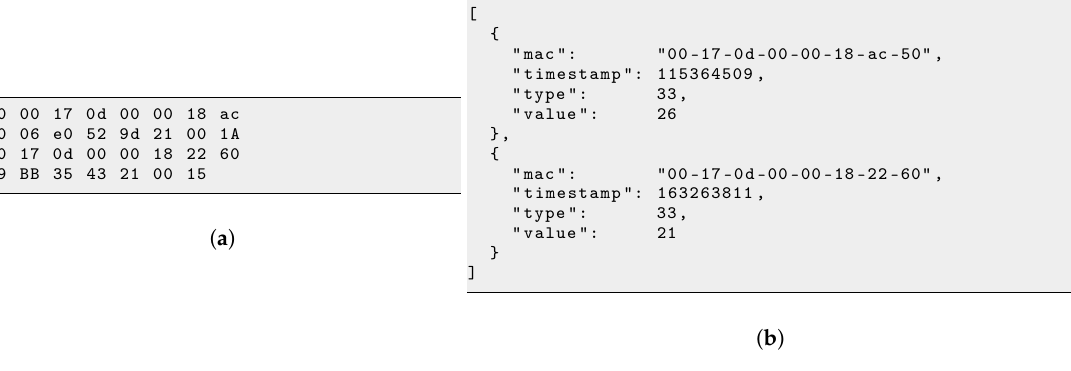
Figure 5. Different encodings of the same example compound SOL object (reproduced from [28]). ( a )binary encoding (31 bytes) ; and ( b ) JSON encoding (156 bytes)